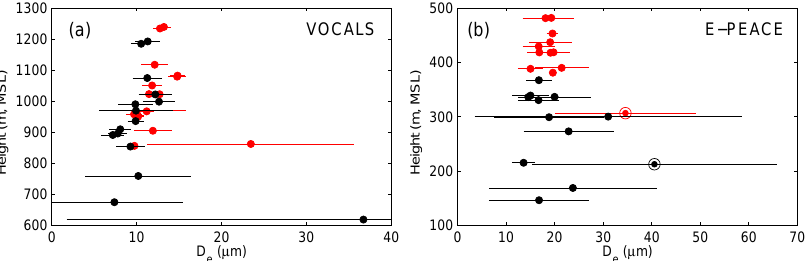
Figure 10. Distribution of effective diameters (mean ± 1 σ) for (a ) VOCALS TO flights and for (b) E-PEACE. Cloud droplets on 11 August are shown as double circles in (b) . Black and red indicate cloud droplets sampled from cloud-base and mid-cloud heights, respectively.